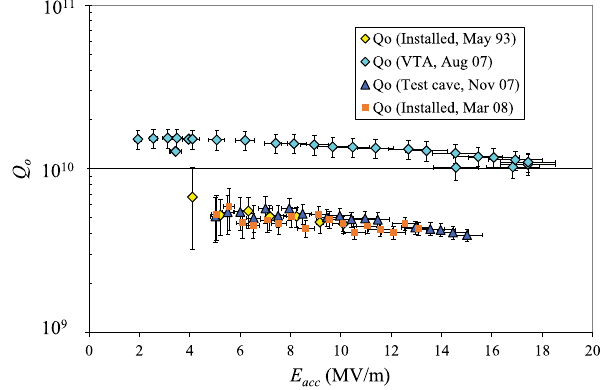
FIG. 22. Performance of cavity IA-085 as installed in CEBAF in 1993, in reworked qualification VTA and cryomodule acceptance tests, and as recommissioned in CEBAF in 2008 (from